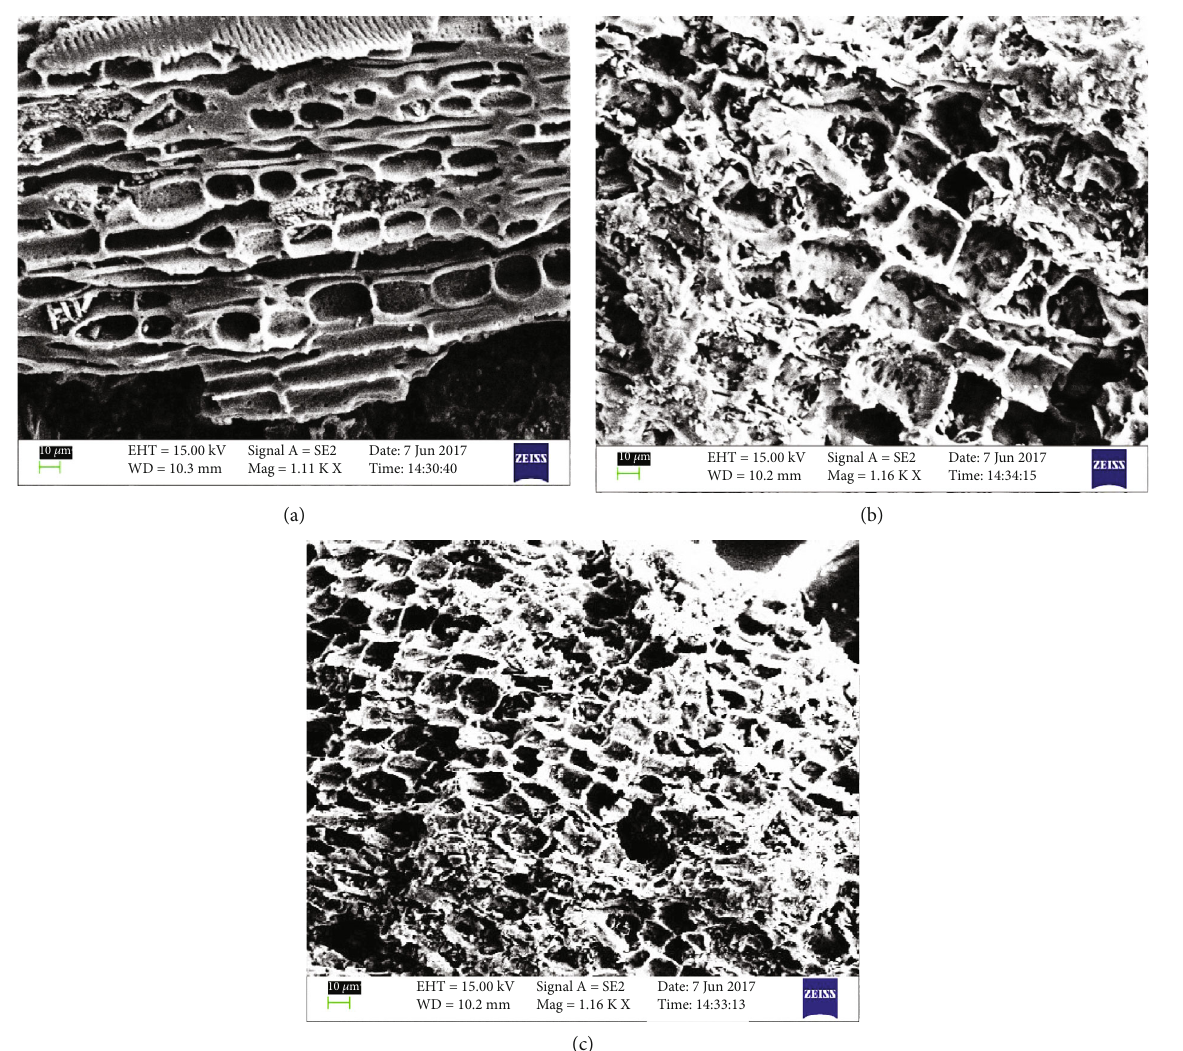
Figure 3: SEM micrograph of (a) HUAC, (b) BG4 loaded HUAC, and (c) AF loaded Figure 4(ii). The UV-vis spectrum of AF dye in Figure 4(ii) (a) has a large peak at 543 nm. This peak is not found in the spectrum (b) that depicts the maximum adsorption of AF dye by HUAC.